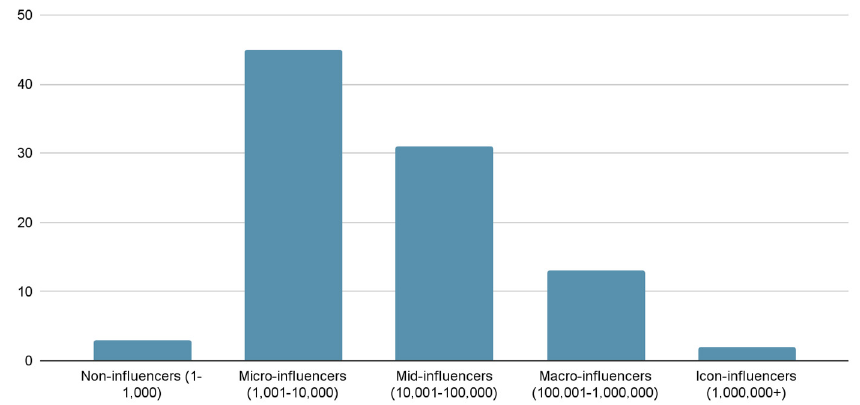
Figure 8. Sample accounts and numbers of followers of the accounts.